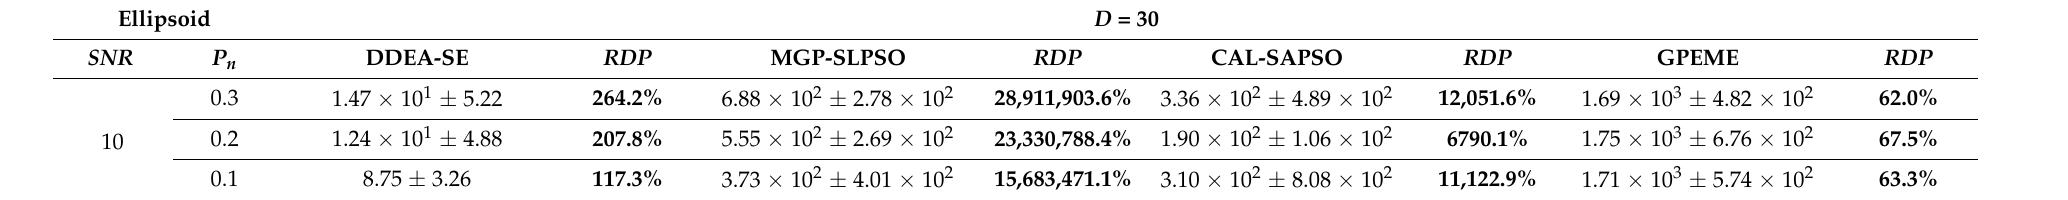
Table A2. Experimental results (with standard deviation) and RDP of DDEAs on 30-dimensional ellipsoid